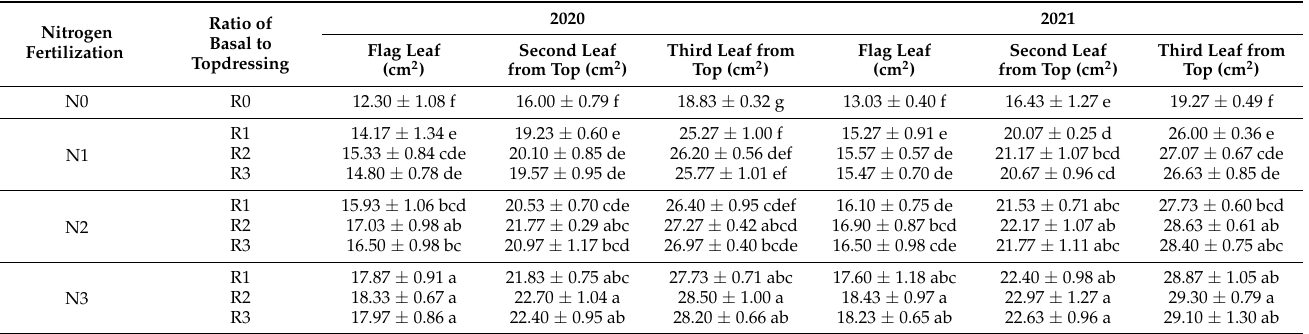
Table 1. Effects of nitrogen application method on wheat leaf area of photosynthetic efficiency at middle of filling stage.